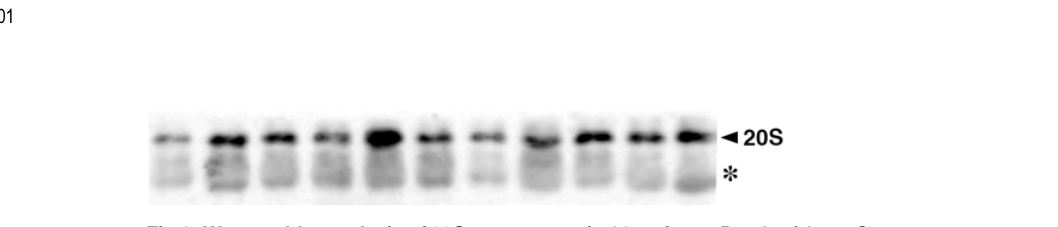
Fig 1. Western blot analysis of 20S proteasome in 11 patients. Bands of the 20S proteasome are detected (arrow head). Laddered bands were also present under the specific bands